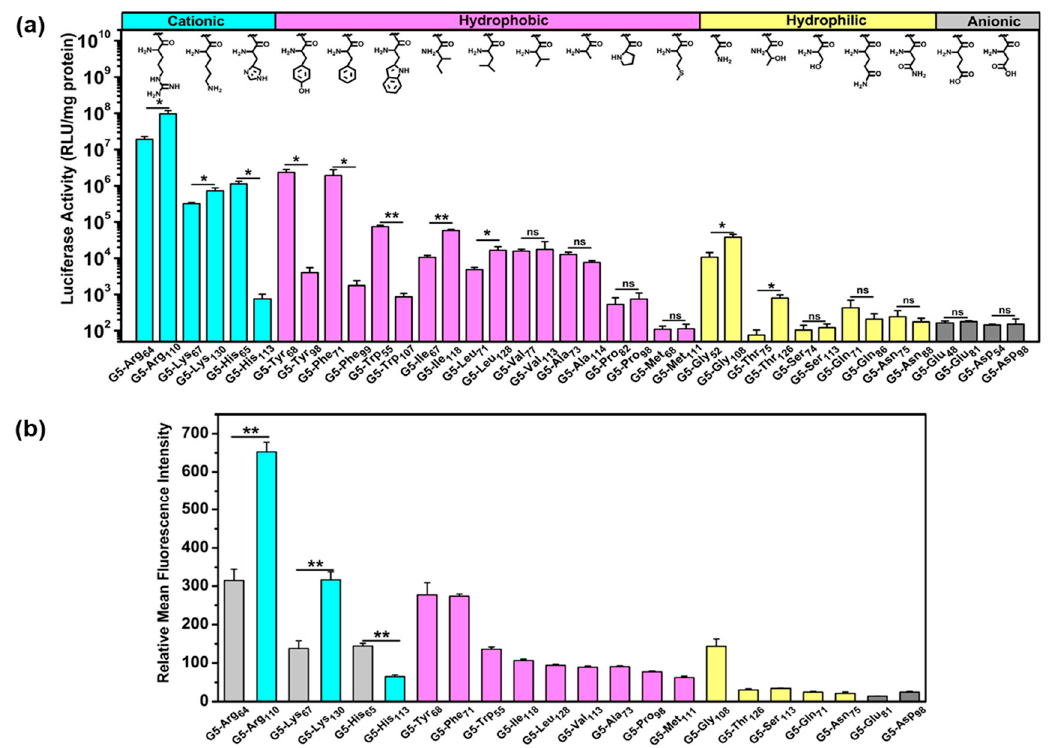
Figure 44. ( a ) The relative luciferase activity of HEK293 cells transfected with various amino acid surface modified G5; PAMAM dendrimers at their optimal N/P ratios for 24 h. Each data point represents mean ± standard deviation ( n = 3), statistically significant differences analyzed by students’ t -test are denoted by * p < 0.05 and ** p < 0.01, ns represents non-statistical significance. ( b ) The cellular uptake efficacy of dendrimer polyplexes derived from the various amino acid surface modified G5; PAMAM dendrimers. The polyplexes were labeled with YOOYO-1 and the cellular uptake experiments were conducted on HEK293 cells for 6 hrs. Each data point represents the mean ± standard deviation ( n = 3), statistically significant differences are denoted by ** p < 0.01. Reprinted with permission from [94]. Copyright 2016 Elsevier.